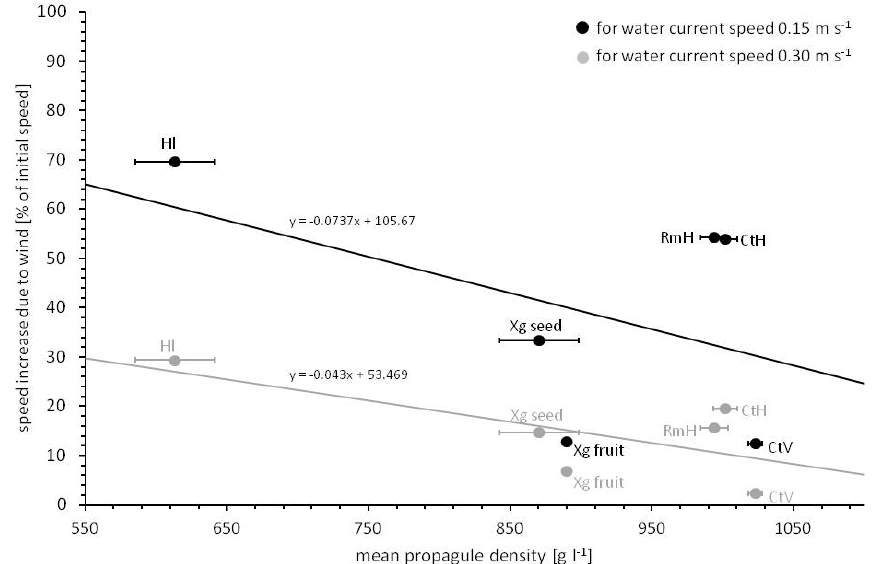
Fig. 5. Speed increase due to wind (only for the S-scenario) in relation to propagule density, for a water current velocity of 0.15ms − 1 (black) and 0.30ms − 1